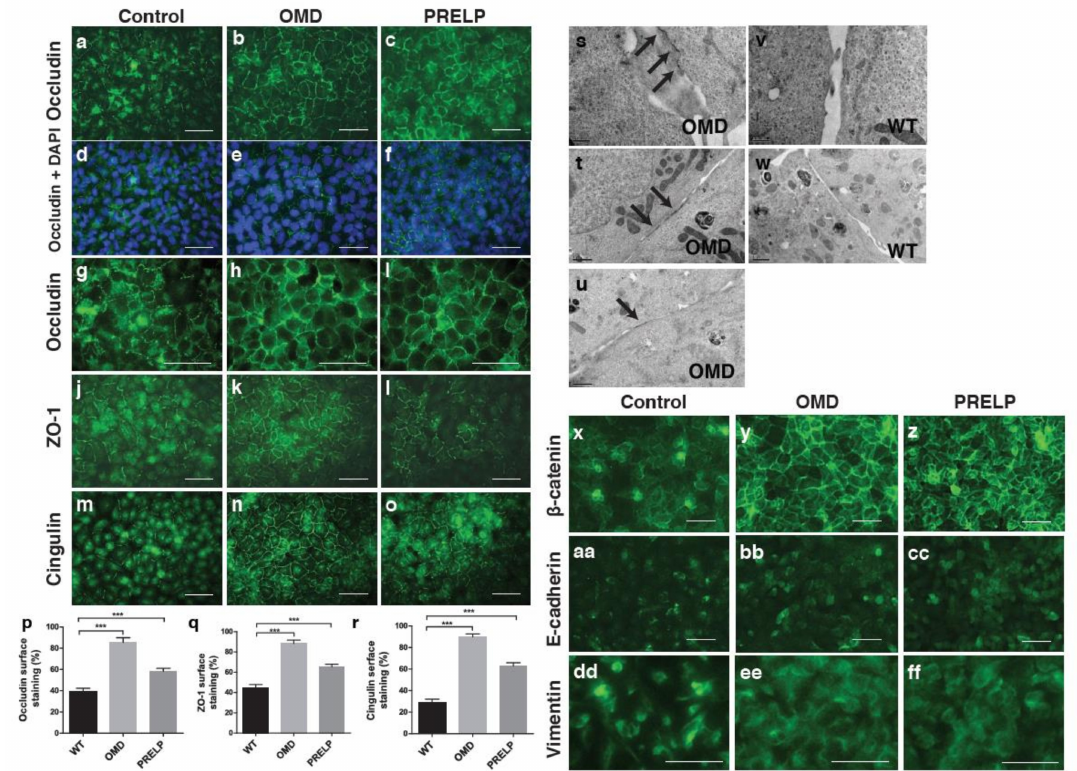
Figure 4. E ff ect of OMD or PRELP overexpression on tight junction in EJ28 cells. ( a – i )